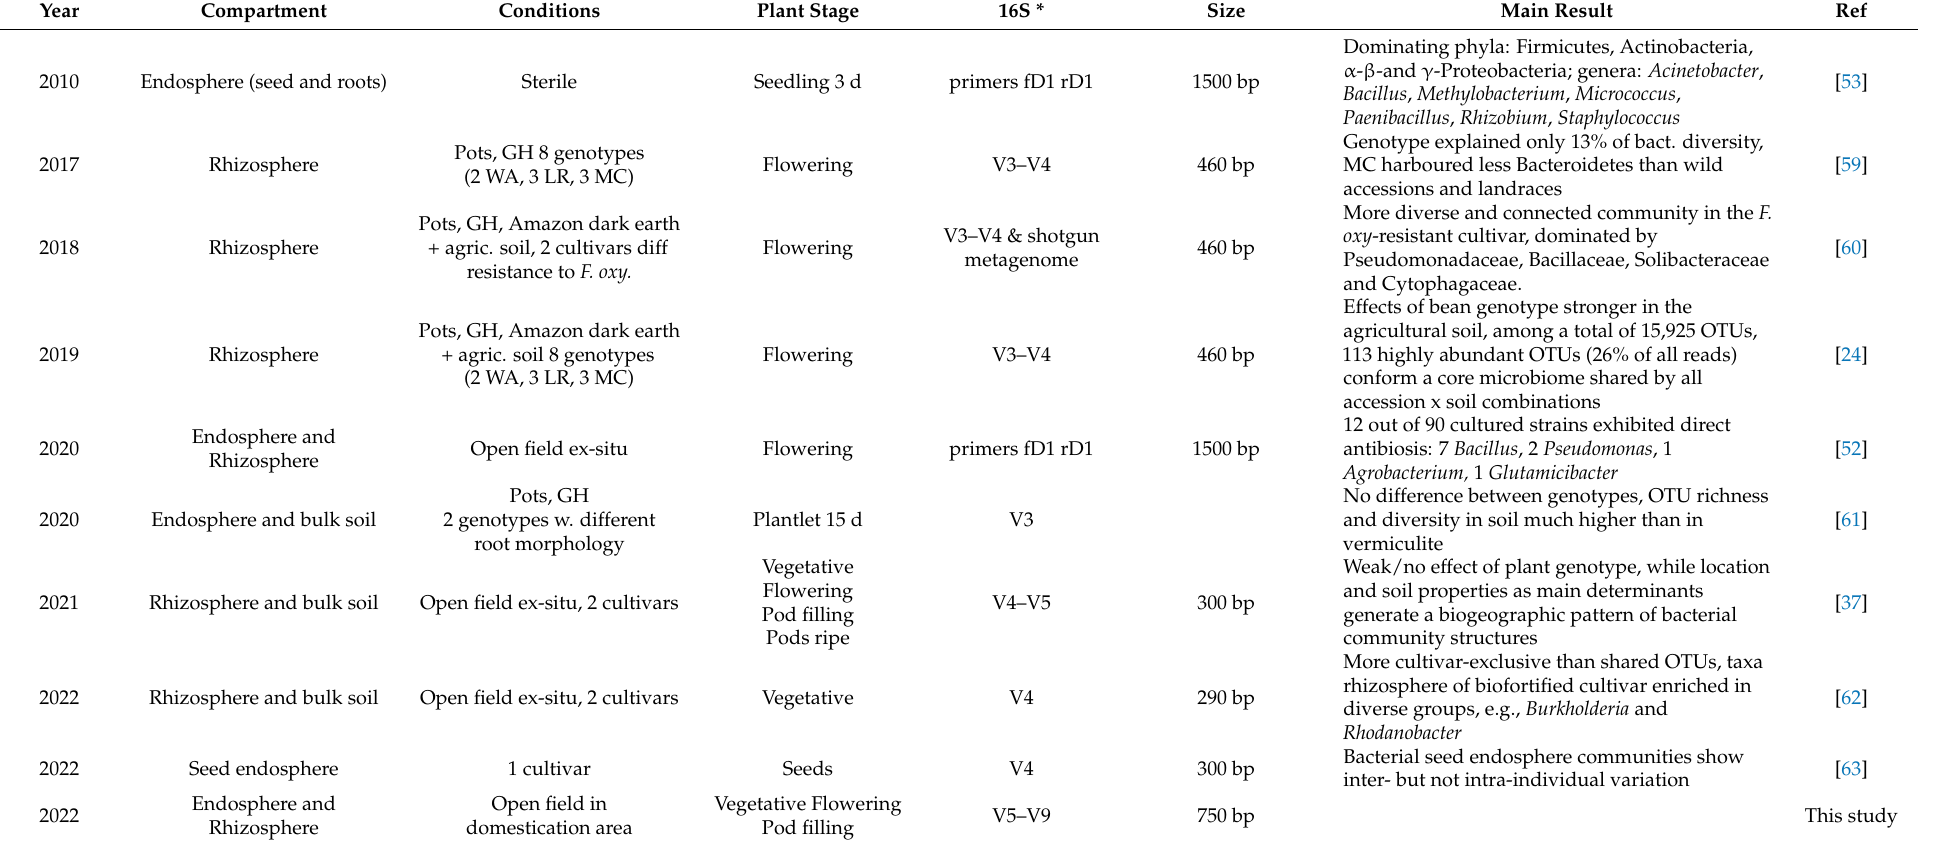
Table 1. Compilation of studies into bacterial root microbiota of common bean ( Phaseolus vulgaris